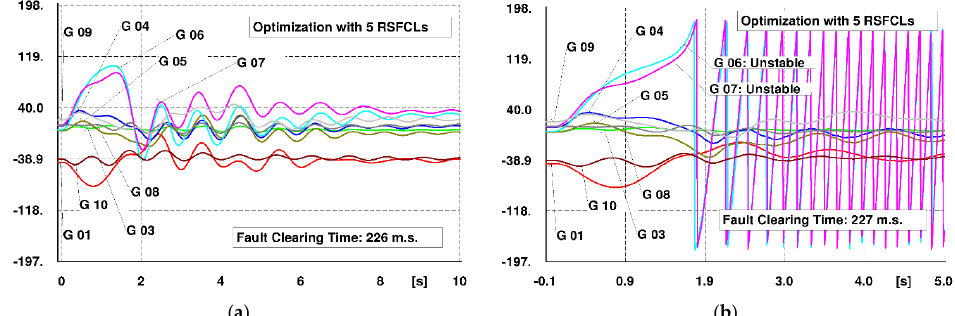
Figure 12. CCT in Scenario 2 (5 RSFCLs) for the considered short-circuit fault. ( a ) FCT = 226 m.s. (stable), ( b ) FCT = 227 m.s. (unstable).